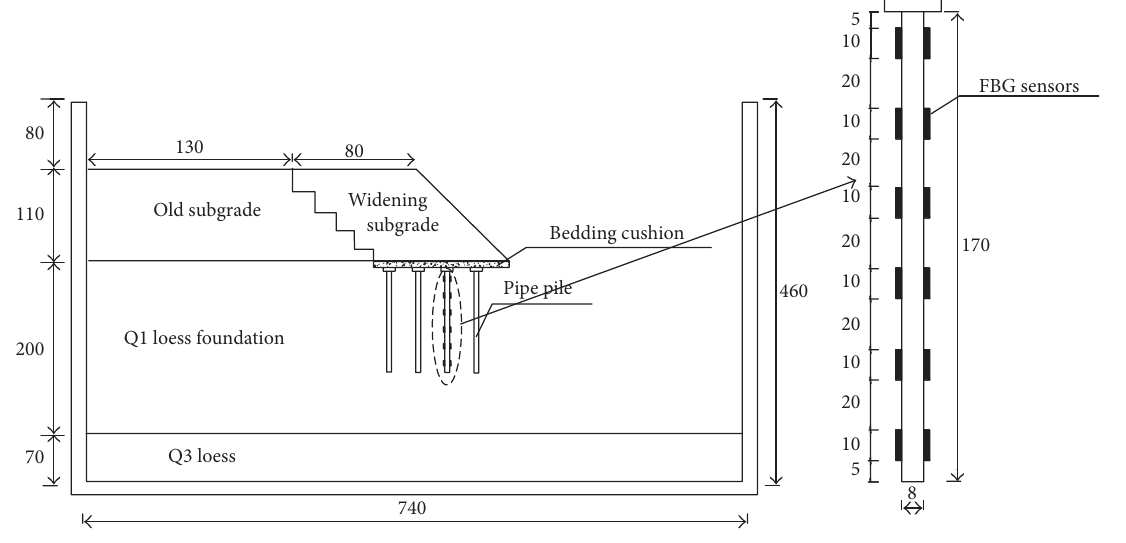
Figure 4: Illustration of the model test (unit:mm).